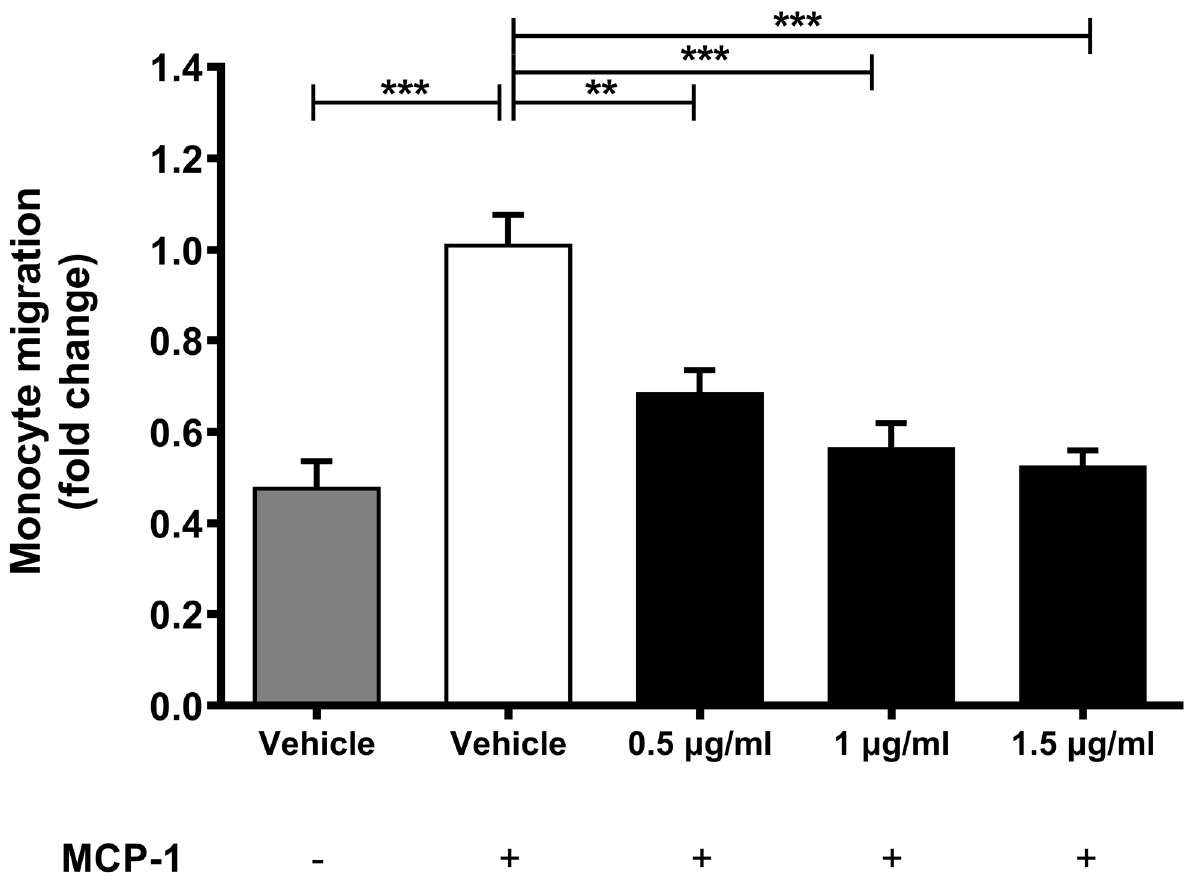
Figure 1. Migration of human monocytes in response to three different concentrations of Lab4b CM. MCP-1-induced migration of THP-1 monocytes was followed in the presence of either the vehicle or three different concentrations of Lab4b CM as shown (0.5 μ g/mL, 1 μ g/mL and 1.5 μ g/mL). Cells treated with vehicle but in the absence of MCP-1 were also included for comparative purposes. Migration was determined as a percentage of total cells and shown as fold change in migration relative to the vehicle control with MCP-1 (20 ng/mL), which was arbitrarily assigned as 1. Data are mean ± SEM from five independent experiments and statistical analysis was carried out on log transformed data using one-way ANOVA with the Bonferroni post-hoc test (**, p ≤ 0.01; ***, p ≤ 0.001).